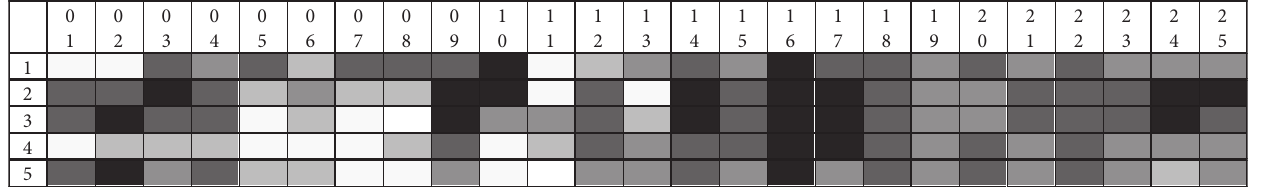
Table 11: Visualization of decision-maker ratings.